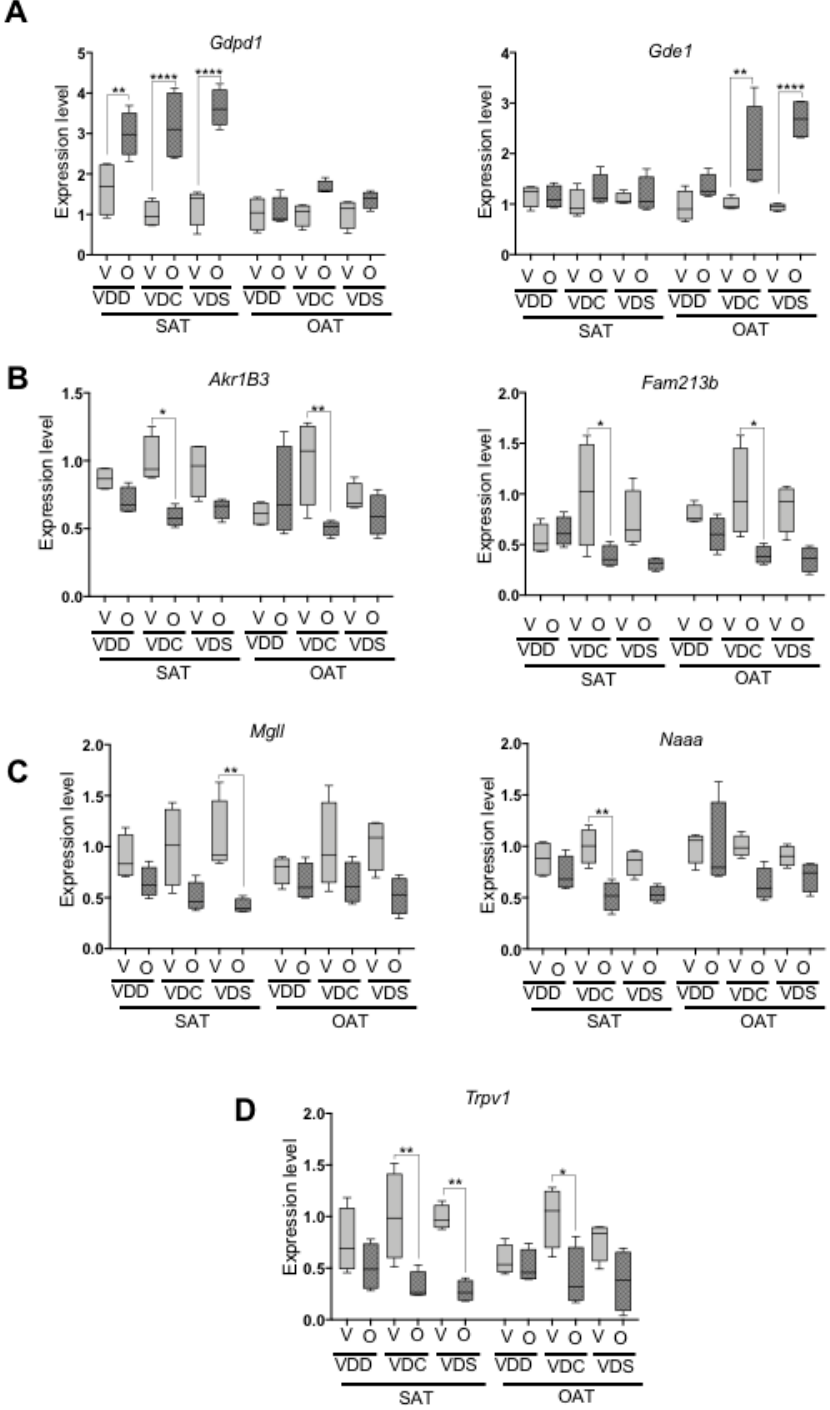
Figure 3. mRNA expression levels of eCBome related genes measured by qPCR, including ( A ) anabolic enzymes involved in NAE biosynthesis, ( B ) anabolic enzymes involved in synthesizing prostaglandins and prostaglandin-related lipids from fatty acids or endocannabinoidome (eCBome) mediators, respectively, ( C ) catabolic enzymes and ( D ) one selected receptor. Data are shown as a box (5th and 95th and mean value) and whisker (minimum and maximum values) plots. * p ≤ 0.05; ** p ≤ 0.01; **** p ≤ 0.001. VDD, Vitamin D Deficiency; VDC, Vitamin D Control; VDS, Vitamin D supplemented; O, Olanzapine; V, Vehicle; SAT, Subcutaneous adipose tissue; OAT, Ovarian adipose